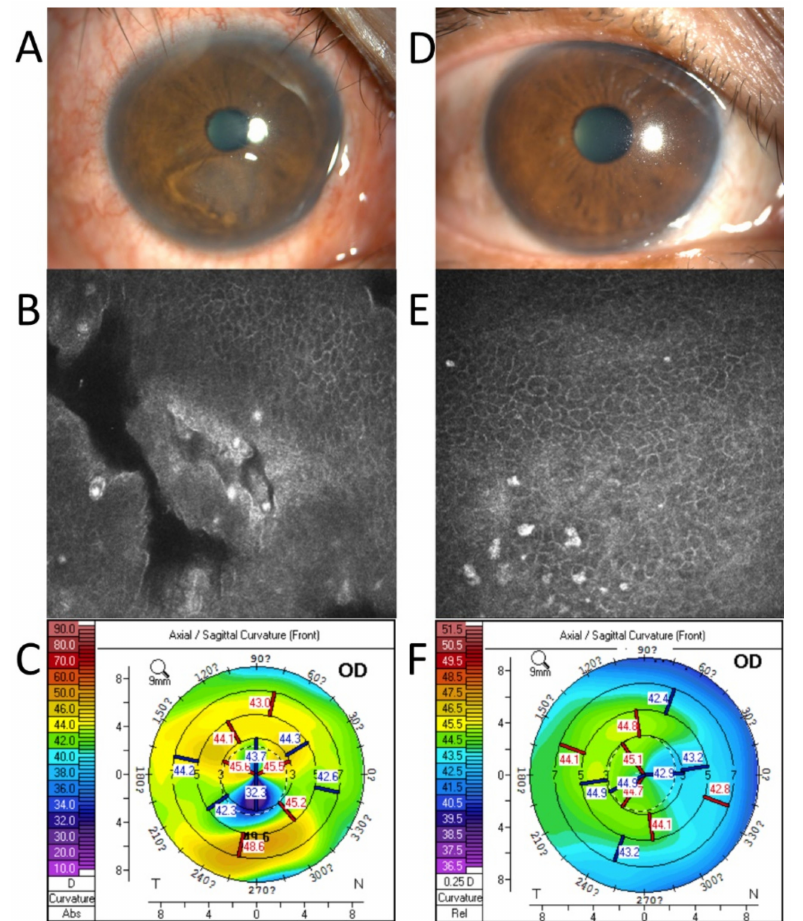
Figure 2. A case example before and 1 month after the coblation. Before the surgery: The corneal epithelium showed obvious detachment under the pupil ( A ); Confocal microscopy revealed obvious gaps ( B ); The corneal topography showed marked corneal astigmatism ( C ). One month after the surgery, the cornea healed ( D ); Confocal microscopy showed an intact corneal epithelium ( E ); Corneal astigmatism decreased significantly ( F